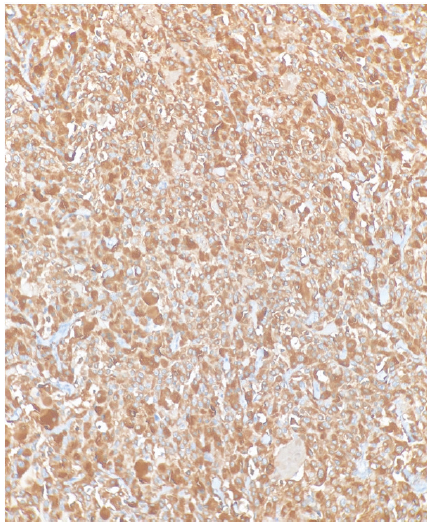
Figure 2: Diffuse cytoplasmic positivity for calcitonin immunohis- tochemical staining was present in medullary thyroid